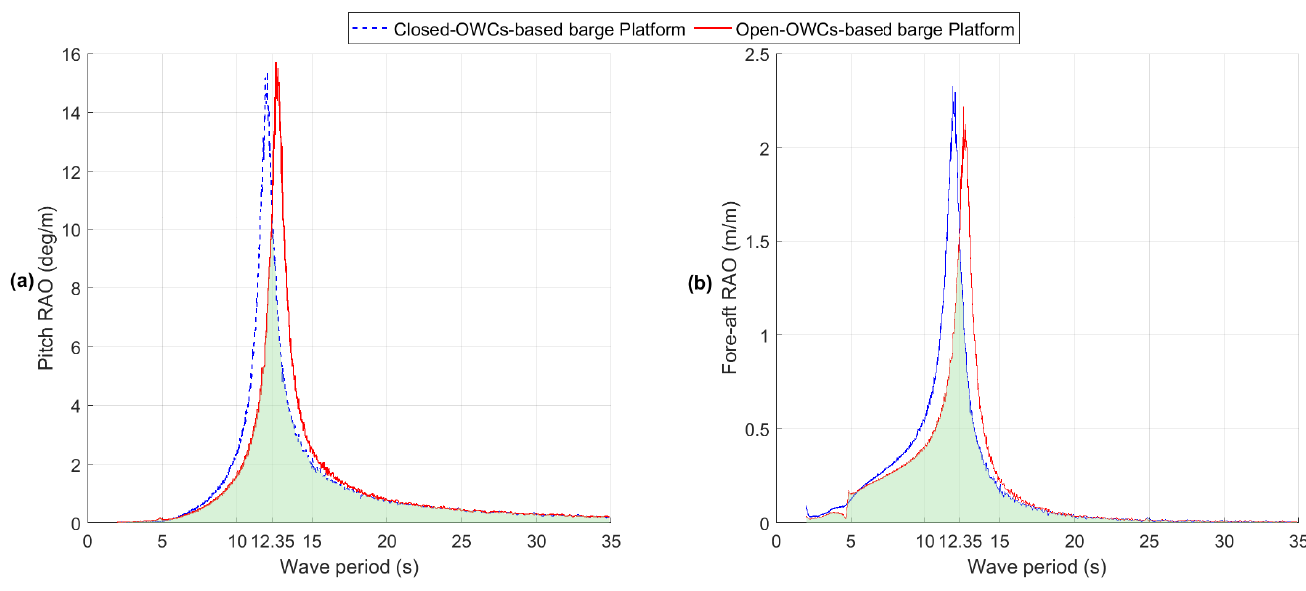
Figure 5. RAOs for ( a ) Pitch. ( b ) Fore-aft.